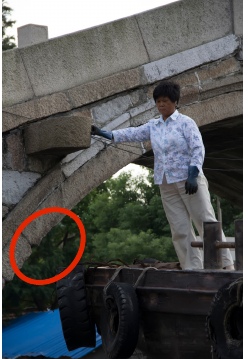
Figure 10. A ship passing the bridge with extreme carefulness and possibility of collision